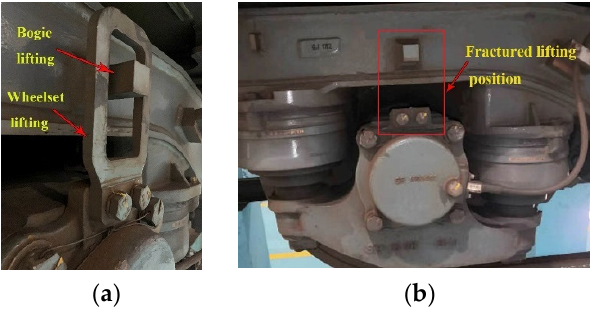
Figure 1. Wheelset lifting fracture: ( a ) full view of the lifting mechanism; ( b ) fractured lifting position.